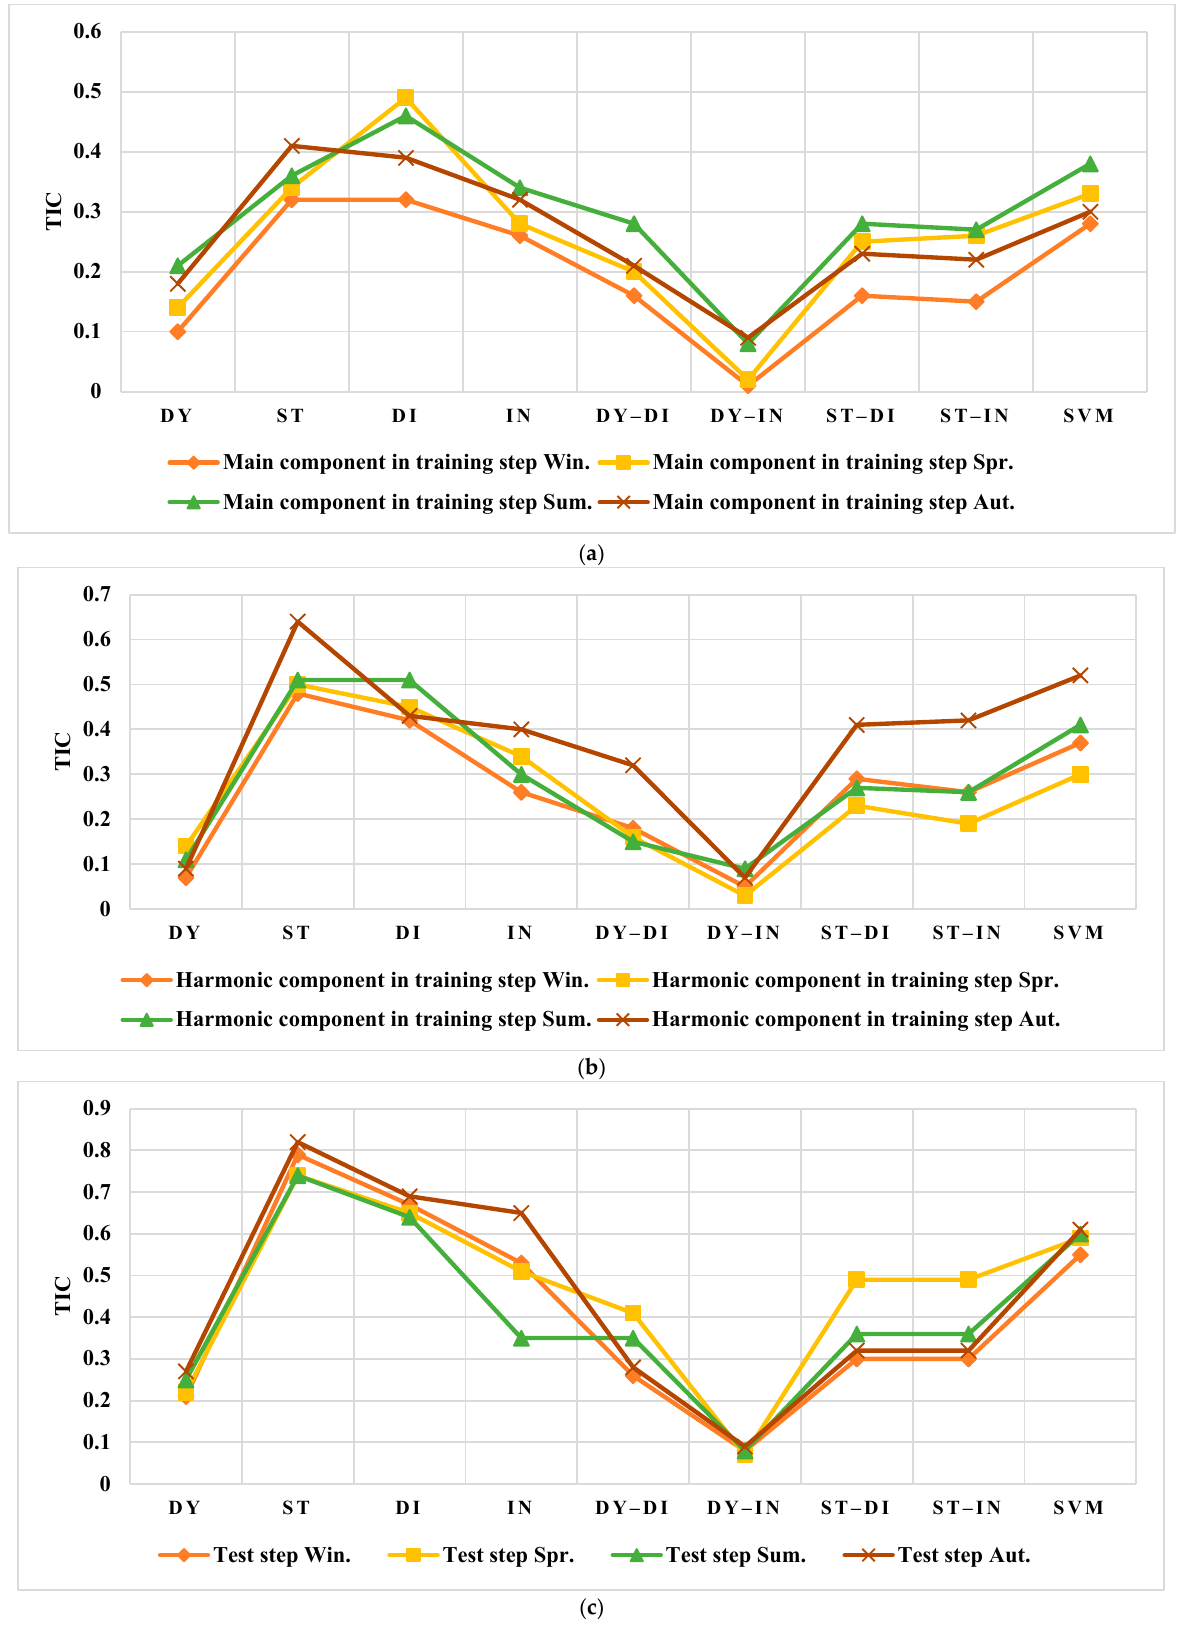
Figure 22. The results of TIC for the US: ( a ) Main Component in training step, ( b ) Harmonic Component in training step, ( c ) Test step